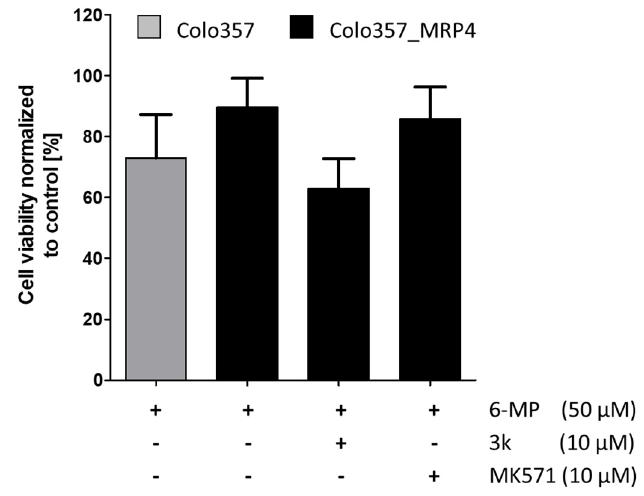
Figure 1. Effect of the symmetric cage compound 3k on cell viability of MRP4 expressing Colo357 pancreatic cancer cells (Colo357_MRP4). Cells were incubated with 50 µM 6-mercaptopurine (6-MP) in the absence or presence of 10 µM compound 3k or the unselective MRP4 inhibitor MK571 for 48 h at 37 °C and thereafter cell viability was assessed using an MTT assay as described in the Section 3. Values represent mean ± SEM of three independent experiments. Due to an insolubility of 6-MP at higher concentrations the effect was determined at the given one. Alternatively, the measurement of a concentration-dependent effect and the depiction in complete sigmoid curves was not possible with reliable values.